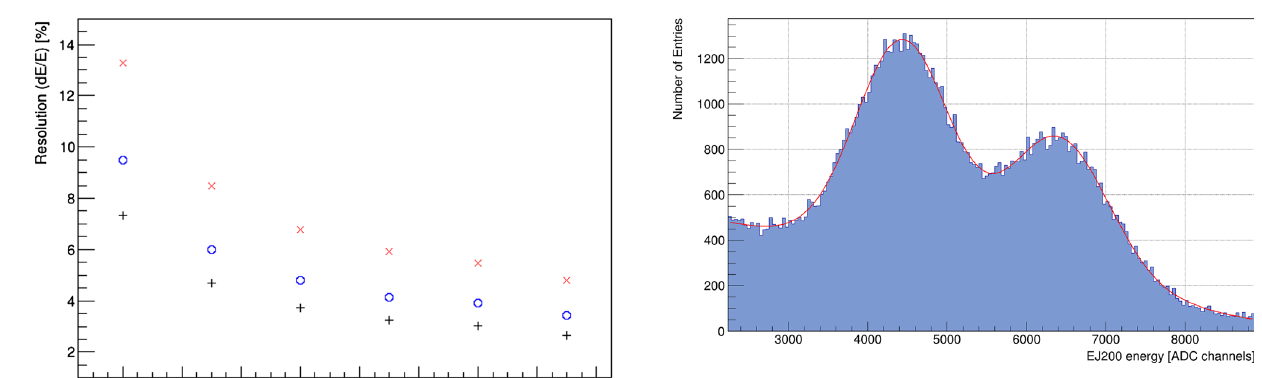
Fig. 24 Pseudo-peaks generated in the EJ200 spectrum by the projec- tions,atfixedenergiesmeasuredintheNaI(Tl)detector,oftheCompton scattering events of 1173 MeV and the 1332 MeV γ